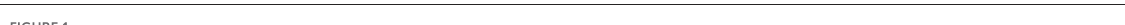
FIGURE1 left ventricle (LV) with the cursor parallel to the mitral inflow (i). CMME analysis using MATLAB software and generation of the 3D temporal and spatial profiles of the IVPG using Euler’s equation over a percent of time of systolic duration from the complete closure of the aortic valve to the end of diastole. The z-axis is the distance (mm) from the apex to the mitral valve (base) (ii). Two-dimensional graph of the temporal profile of the IVPG over % of systole from the aortic valve closure to the end of diastole showing the peak total IVPG and segmental IVPGs, respectively (1). Two-dimensional spatial profile of the IVPG from the apex to the base (MV) of the heart. The red line represents the spatial profile at peak total IVPG that often happens at the level of the MV. The top and the bottom blue lines represent the inertial and the convective IVPG, respectively. Calculation of the basal and mid-apical segmental IVPGs relied on the rule of LV segmentation (one-third for basal and two-thirds for mid-apical)